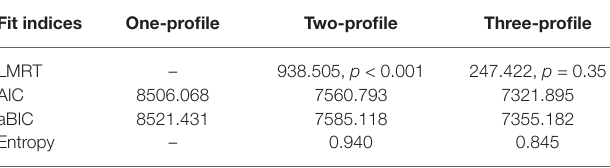
TABLE 3 | Model fit indices for the two-, three-, and four-profile solutions.